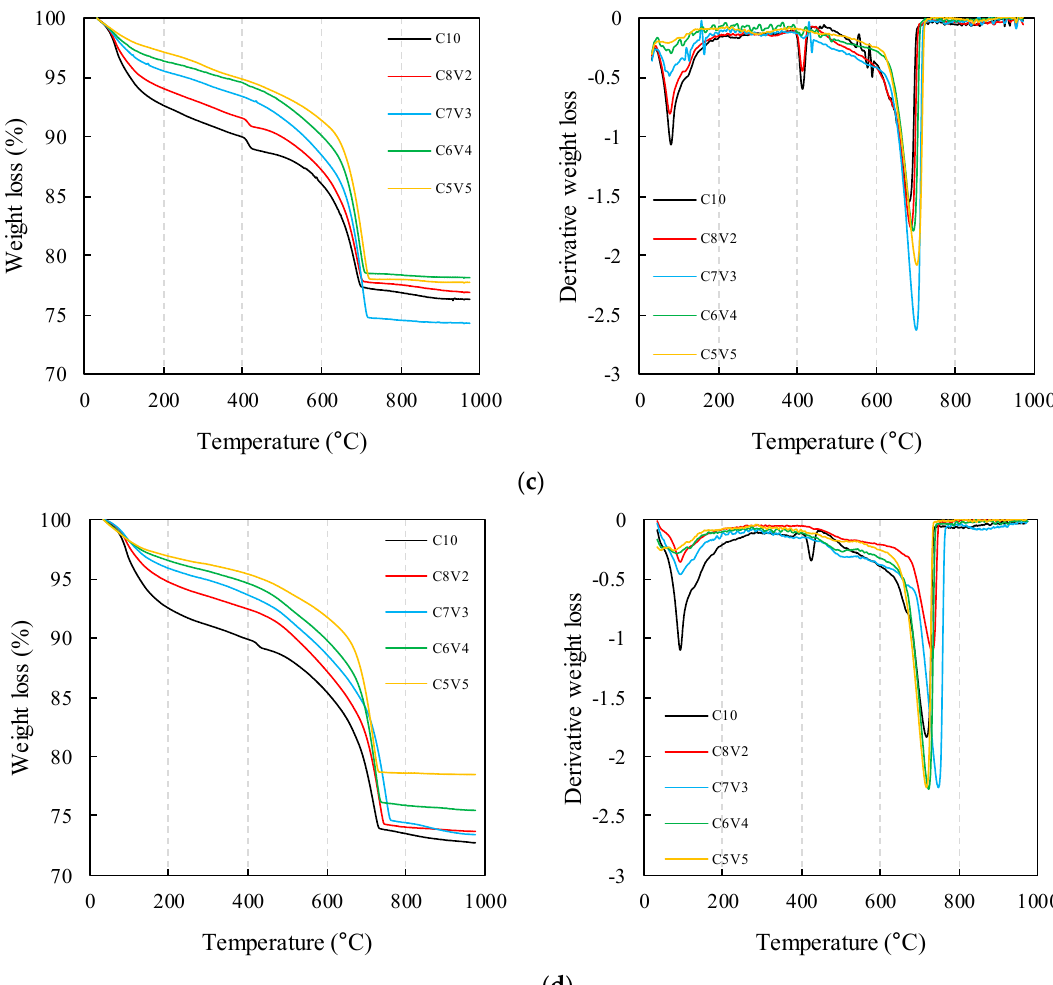
Figure 5. Thermogravimetry/derivative thermogravimetry (TG/DTG) curves of normally cured and carbonation-cured volcanic ash-blended PC: ( a ) Normally cured 7 days; ( b ) normally cured 28 days; ( c ) carbonation-cured 7 days; ( d ) carbonation-cured 28 days. Table 4. Relative weight loss (%) attributed to the decomposition of reaction products at 28 days.